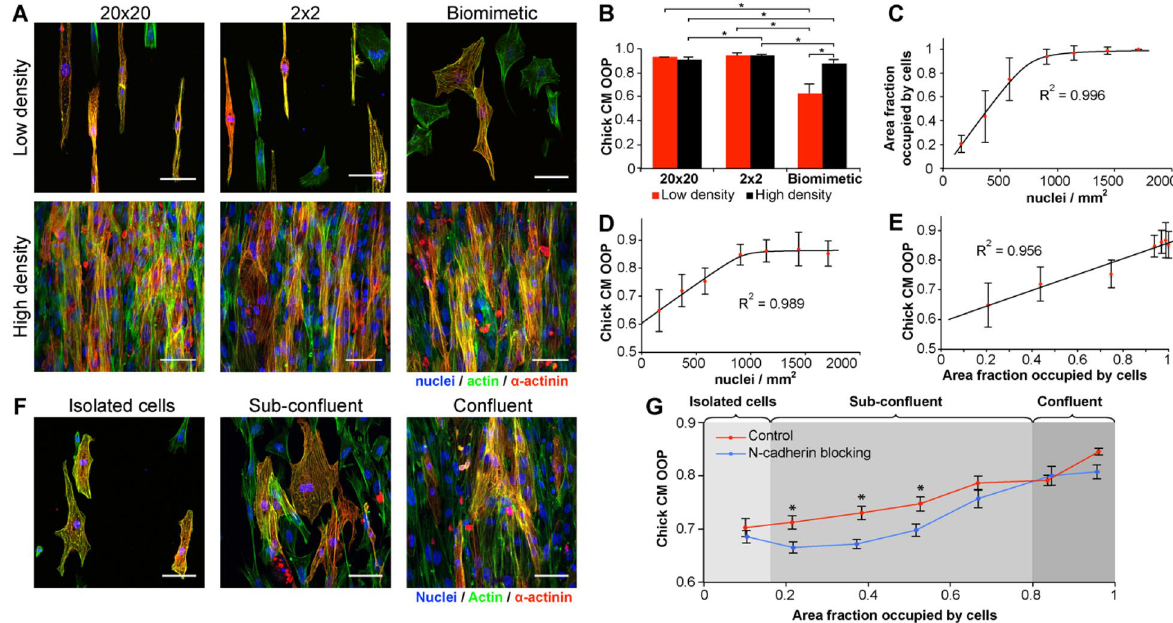
Figure 2. Analysis of enriched embryonic chick cardiomyocytes cultured on the fibronectin micropatterns at various cell densities. ( A ) Representative images showing pattern-dependent differences in cell morphology at low density (isolated cells) and high density (monolayer). ( B ) Chick cardiomyocyte OOP analysis at low and high cell densities (n ≥ 15) showing that only the biomimetic micropattern shows a density-dependent difference in cardiomyocyte alignment. At high density, cardiomyocyte alignment is significantly different between micropatterns, but still achieves a comparable OOP value of ~0.9. Two-way ANOVA with Tukey’s posthoc, * indicates p<0.05, n ≥ 15. ( C ) On the biomimetic micropattern, the area fraction occupied by cells increases linearly with cell density up until ~1000 nuclei/mm 2 , which corresponds to when the cells reach 100% confluence. ( D ) On the biomimetic micropattern, chick cardiomyocyte OOP also increases linearly with cell density up until ~1,000 nuclei/mm 2 , leveling off after confluence is reached. ( E ) Chick cardiomyocyte